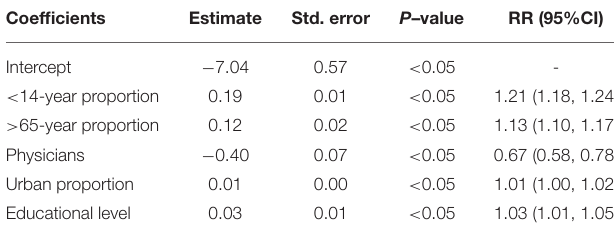
TABLE 2 | The correlation analysis of sociodemographic factors to the ASDR of